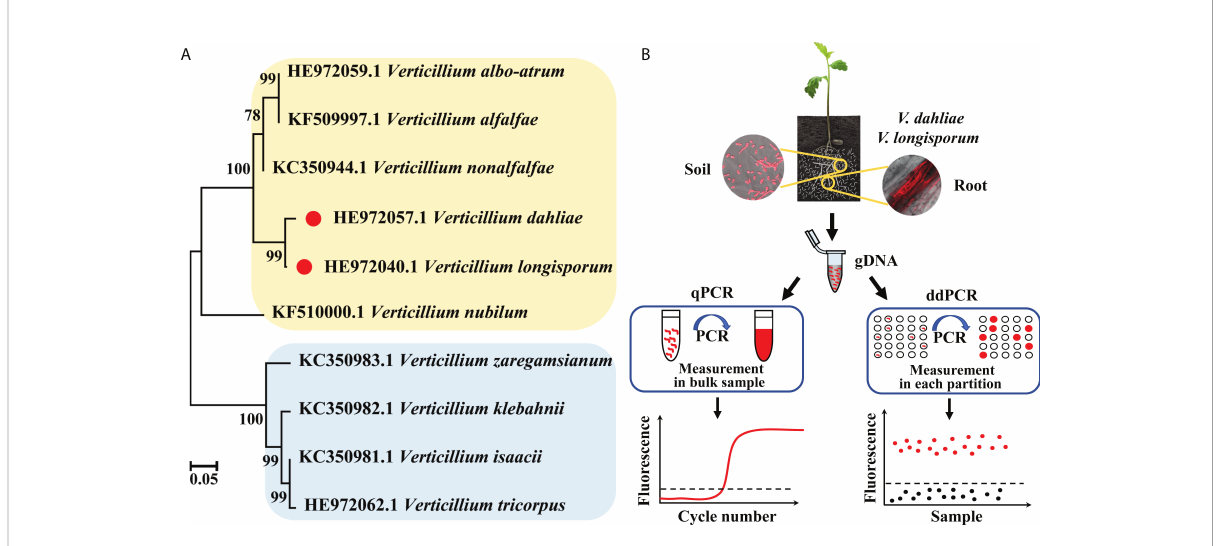
FIGURE 1 (A) Phylogenetic tree of V. dahliae , V. longisporum , and other Verticillium fungi based on IGS sequences. (B) Schematic diagram of the qPCR and ddPCR assays used for quantitative detection of V. dahliae and V. longisporum .